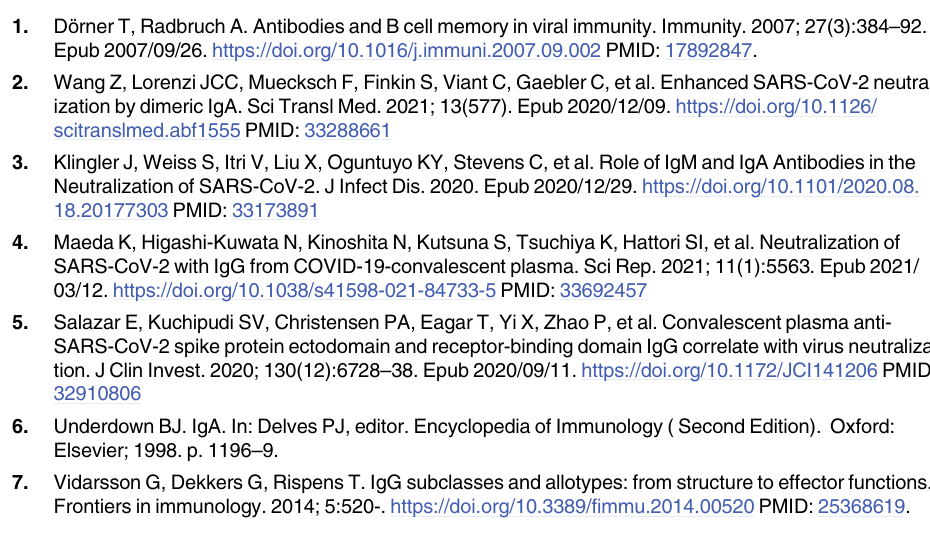
S1 Table. ELISA OD values of participants at different time points after COV ID-19 vac-